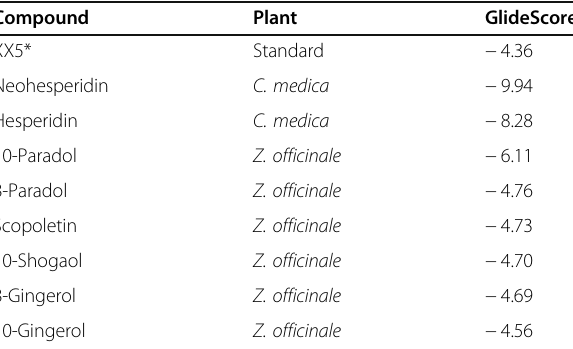
Table 3 Molecular docking results of the ACE-2 and the ligands from the Ayurvedic preparation [4] and the